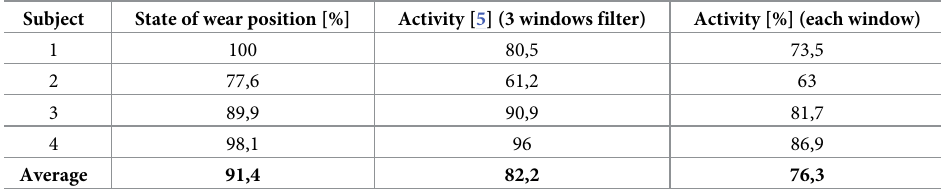
Table 4. Averaged results of the proof-of-concept study with four healthy